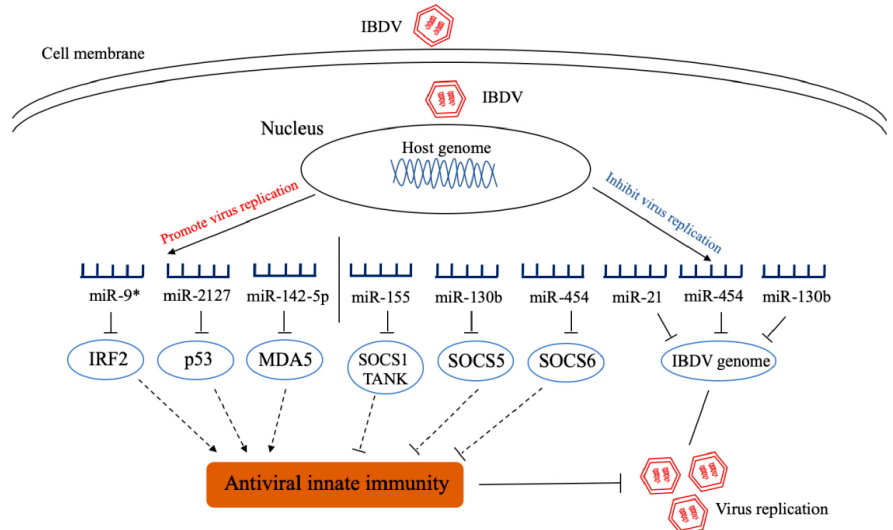
Figure 3. Schematic diagram of the roles of cellular miRNAs in host response to infectious bursal disease virus (IBDV) infection and viral replication. After IBDV infection, some cellular miRNAs were di ff erentially expressed. These miRNAs promote or inhibit virus replication by directly targeting the genome of IBDV or molecules that regulate innate immunity. IRF2: interferon regulatory factor 2; MDA5: melanoma di ff erentiation associated gene 5; SOCS1: suppressor of cytokine signaling 1; TANK: TRAF family member associated NF- κ B activator; SOCS5: suppressor of cytokine signaling 5; SOCS6: suppressor of cytokine signaling